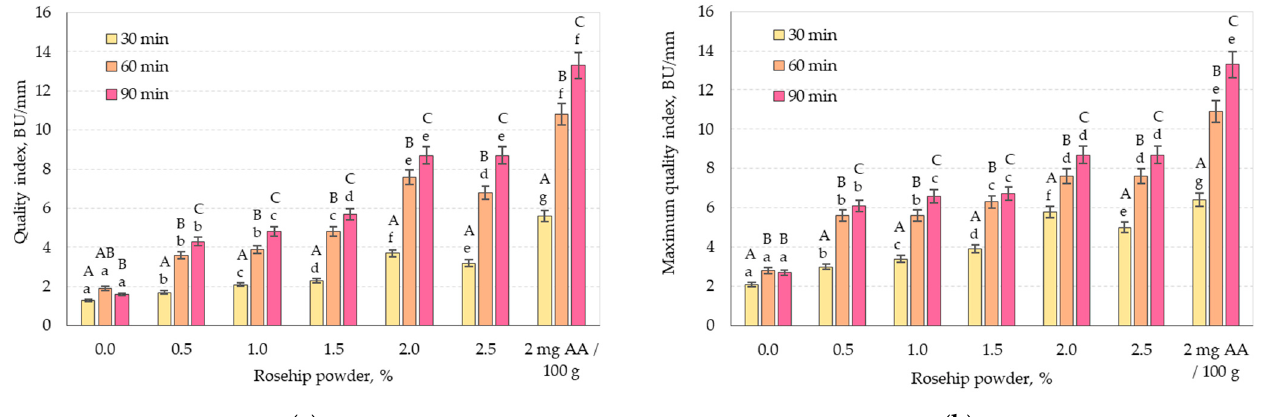
Figure 3. Ratio numbers as a function of Rp addition: ( a ) Ratio number, R 50 / E , in BU/mm; ( b ) Maxi- mum ratio number, R max / E , in BU/mm. Di ff erent capital le tt ers represent statistically di ff erent mean values ( p ≤ 0.01) of each sample for di ff erent times (30, 60, and 90 min). Di ff erent lower-case le tt ers are responses statistically di ff erent ( p ≤ 0.01) of all samples for each time (30, 60, and 90 min). BU— Brabender Units, AA—ascorbic acid.